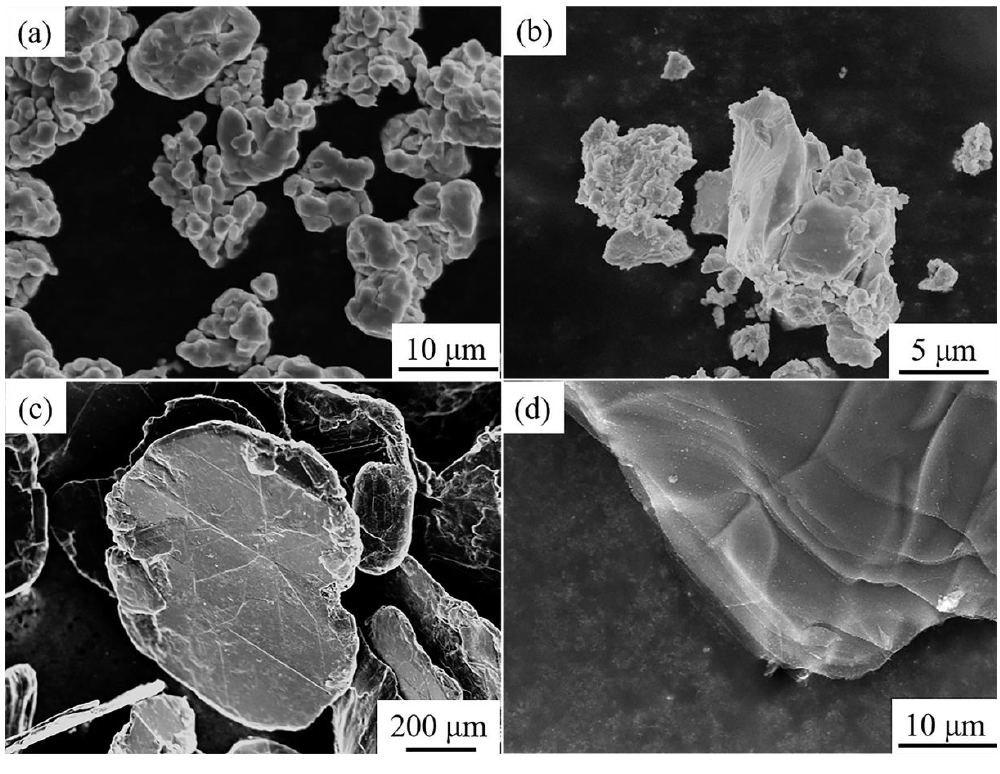
Figure 1. SEM images of raw materials: ( a ) electrolytic copper powder; ( b ) Zr-Cu alloy powders; ( c , d ) flake graphite.